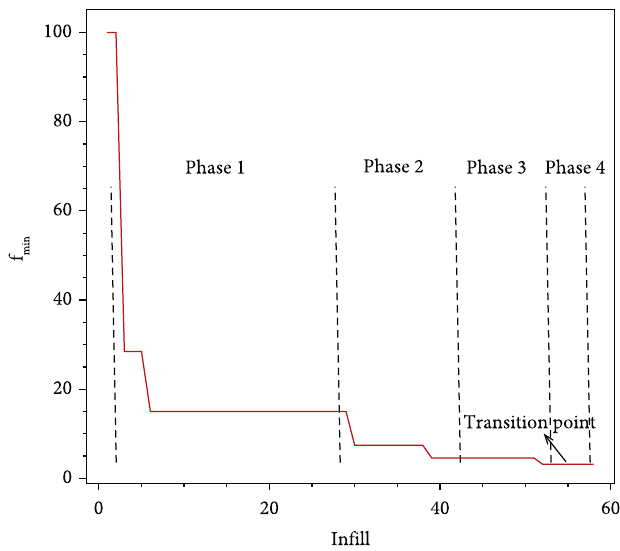
Figure 8: Convergence history of the objective function.